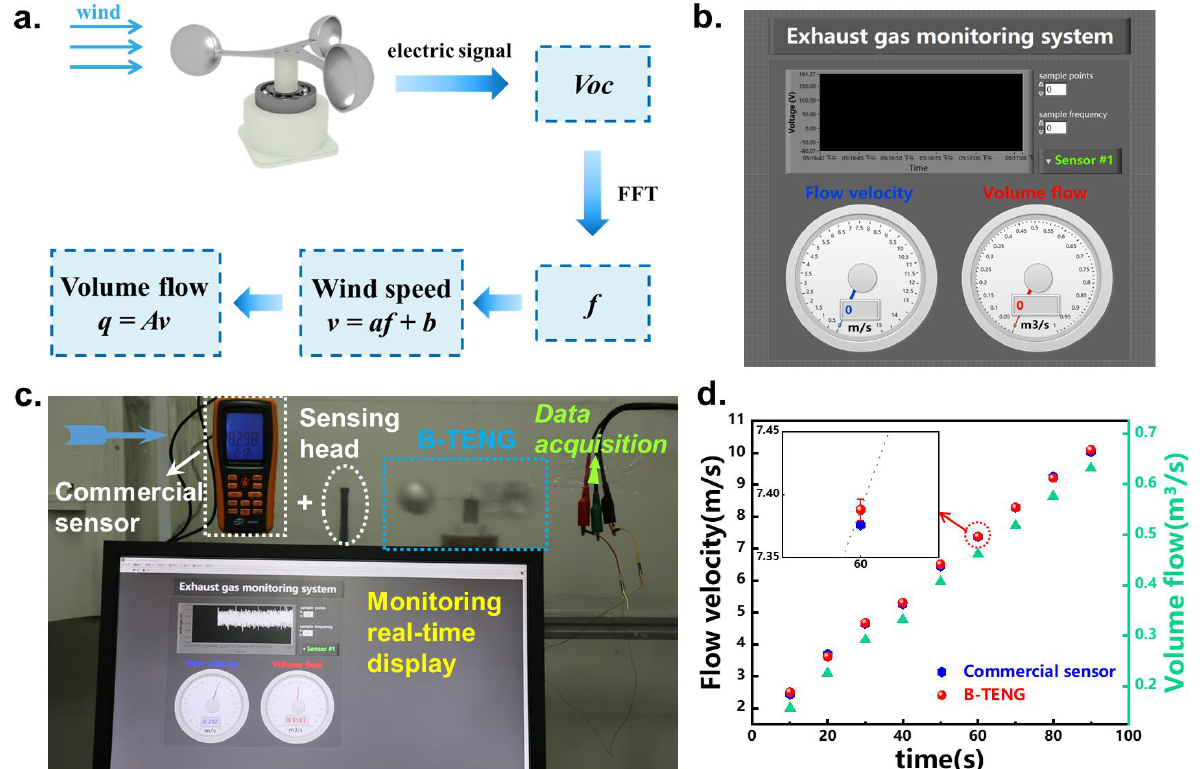
Figure 5. Demonstration of the B-TENG as gas flow sensor. ( a ) The logic flowchart for gas flow sensing by the B-TENG; ( b ) Display interface based on LabView; ( c ) Test system for the demonstration of the B-TENG as gas flow sensor; ( d ) Gas flow sensing comparison between the commercial sensor and B-TENG.